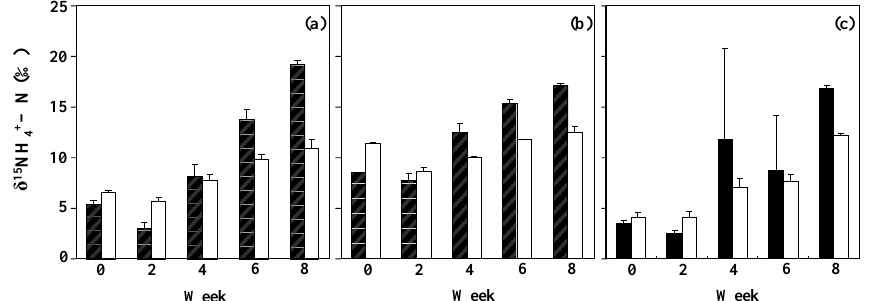
Figure 2. δ 15 N of NH + of the mixed samples just after the turning events. The black bars indicate the compost with bulking agent (10% w/w ) 4 and the white bars indicate the compost without bulking agent. (a) – (c) indicate the compost runs 1–3. The error bars indicate the standard deviation ( n = 2).